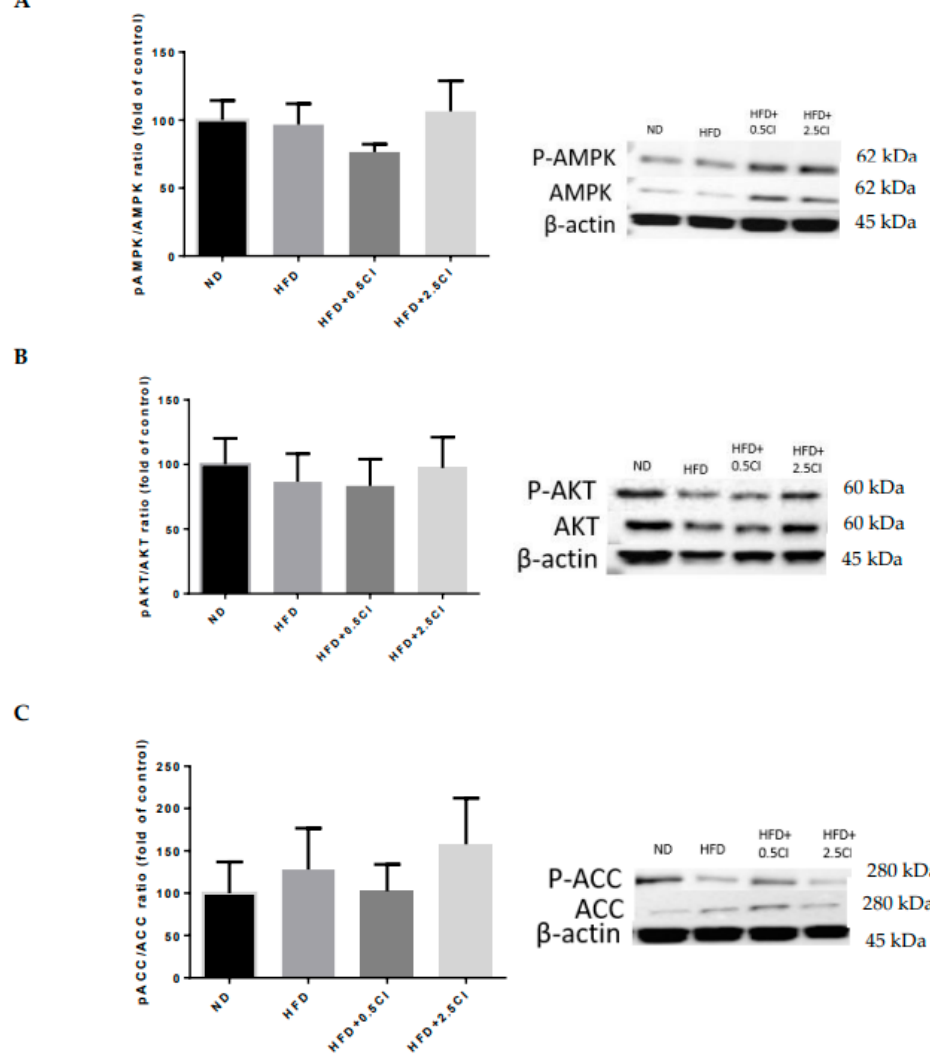
Figure 6. Effect of Chiliadenus iphionoides supplementation on proteins related to liver carbohydrate and lipid metabolism. Male C57BL/6J mice were fed with normal diet (ND), high-fat diet (HFD), high-fat diet + 0.5 mg/kg Chiliadenus iphionoides (HFD + 0.5CI), high-fat diet + 2.5 mg/kg Chiliadenus iphionoides (HFD + 2.5CI) for fifteen weeks. ( A ) Protein expression of pAMPK/AMPK ratio; ( B ) Protein expression of pAKT/AKT ratio; ( C ) Protein expression of pACC/ACC ratio. Values are expressed as mean ±SEM.